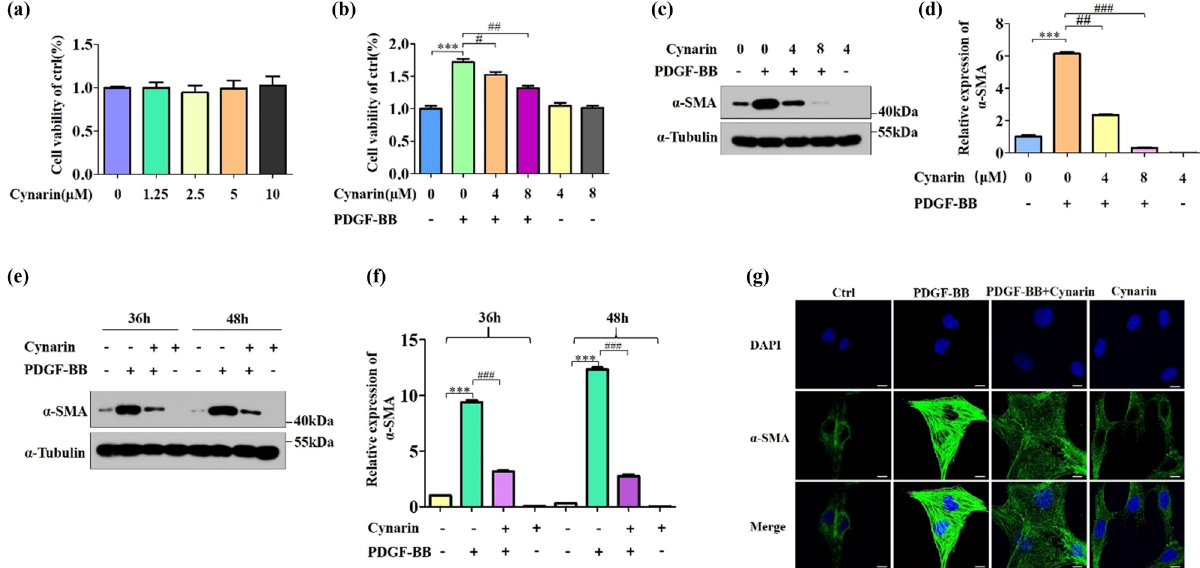
Figure 3: Cynarin inhibits PDGF - BB - induced HSC proliferation and activation. ( a ) The e ff ect of cynarin on quiescent HSC proliferation. ( b ) The e ff ect ofcynarinon PDGF - BB - induced HSC proliferation. ( c – g ) Inhibitory e ff ect ofcynarin on α - SMA expression induced by PDGF - BB ( 10 ng/mL ) as indicated. *** p < 0.001 vs vehicle group, # p < 0.05 vs PDGF - BB group, ## p < 0.01 vs PDGF - BB group, ### p < 0.001 vs PDGF - BB group, n =